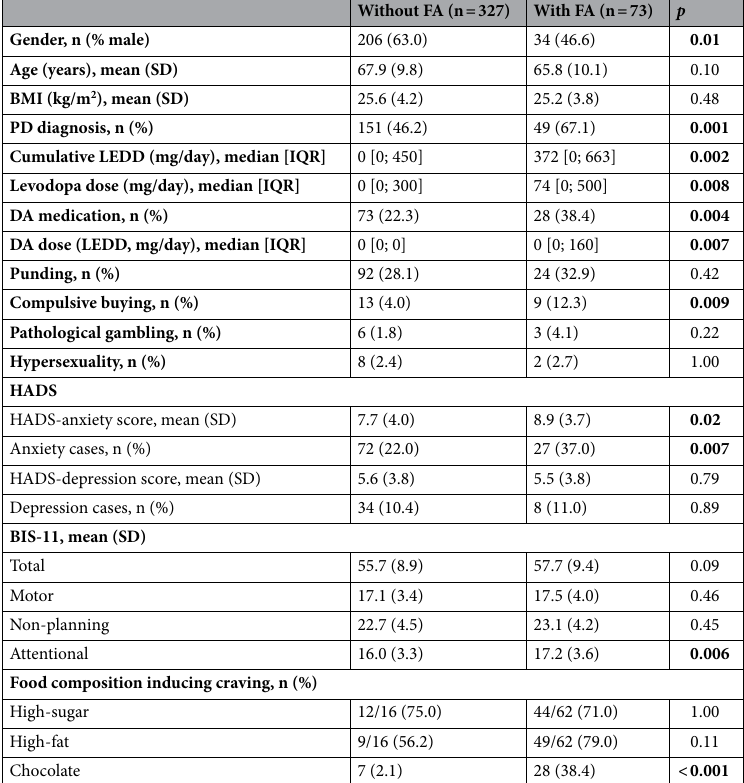
Table 3. Characteristics of food addiction (FA) subjects (n = 400). Bold values indicate statistical significance ( p < 0.05). BIS-11 Barratt impulsiveness scale, BMI body mass index, DA medication dopamine